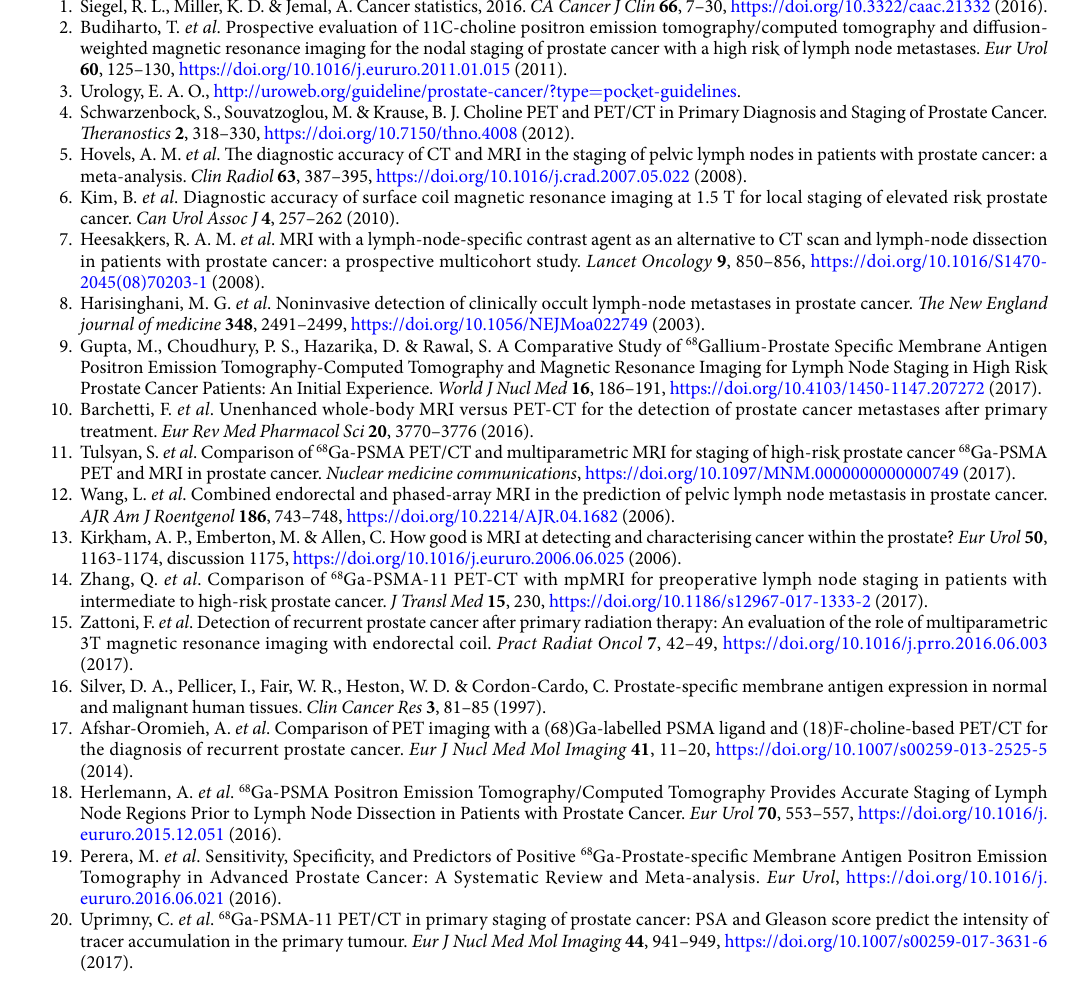
node might be more likely to have more conspicuous lymph nodes 36 . Multi-level models include such effects and can even capture person-wise differences in diagnostic accuracy (called random slope models). In our analyses below, we tested for each predictive model whether such person-wise differences were statistically significant. The common properties of a diagnostical test (sensitivity, specificity, positive predictive value and negative predictive value) were calculated from logistic regression and confidence intervals (CI 95%) were given through logistic regression using the method proposed by Coughlin et al . 37 . When no confidence intervals could be calculated due to perfect agreement of MRI and PET-CT, it is highlighted in the tables. A p-value p < 0.05 was considered statistically significant.